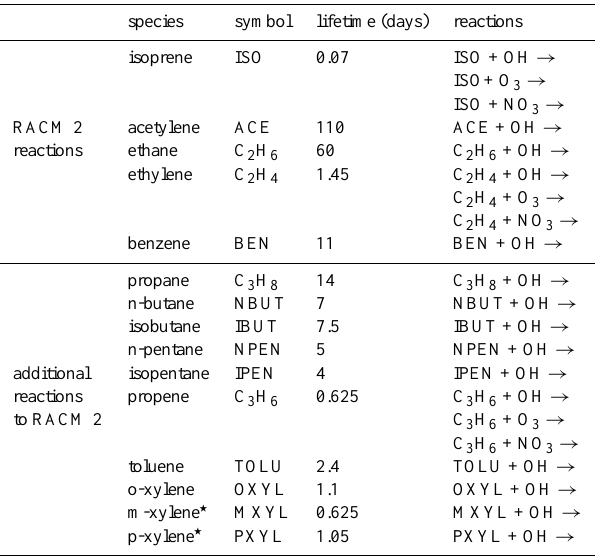
Table 1. The volatile organic compounds, their (indicative) lifetime and